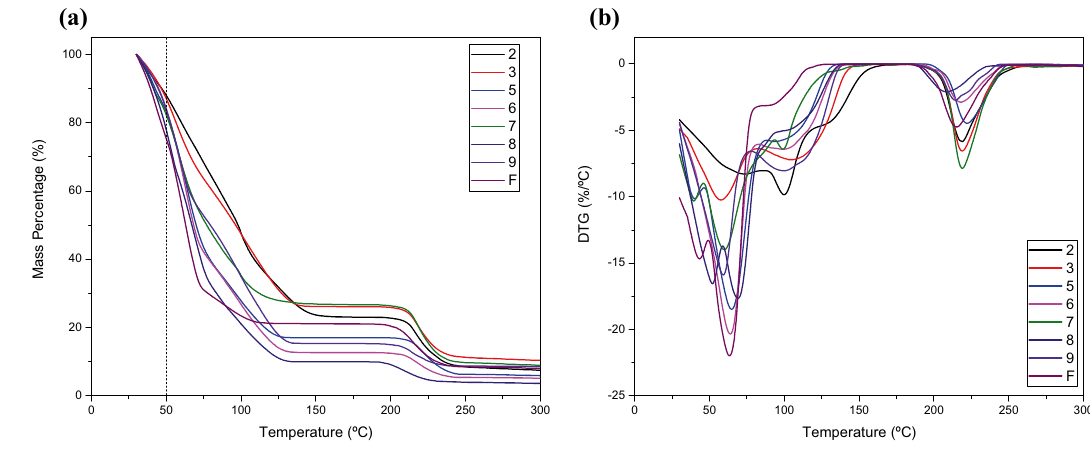
Fig. 3 Thermogravimetric curves (TGA) ( a ) and their derivatives (DTG) ( b ) of microemulsion formulations (2, 3, 5, 6, 7, 8, 9 and